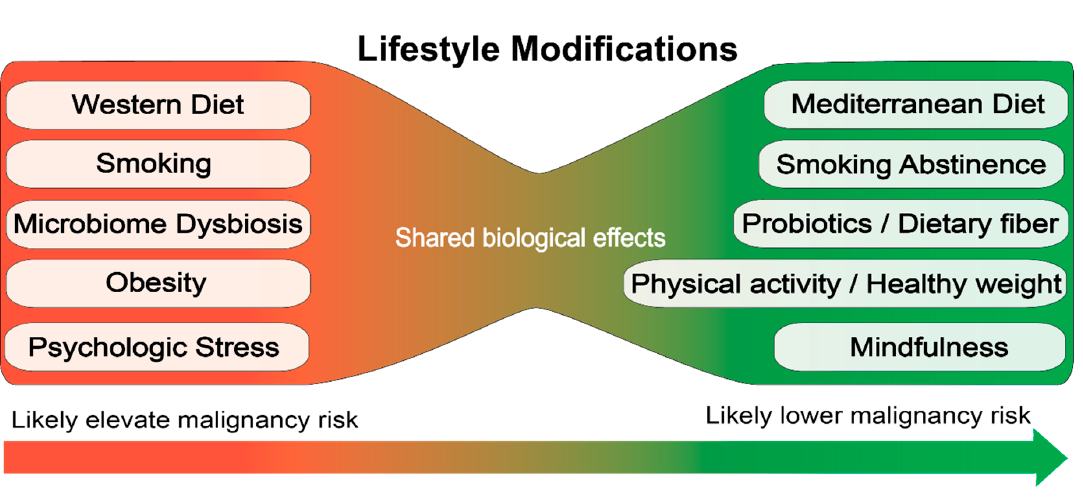
Figure 2. Proposed lifestyle modifications for prevention of hematologic malignancies.